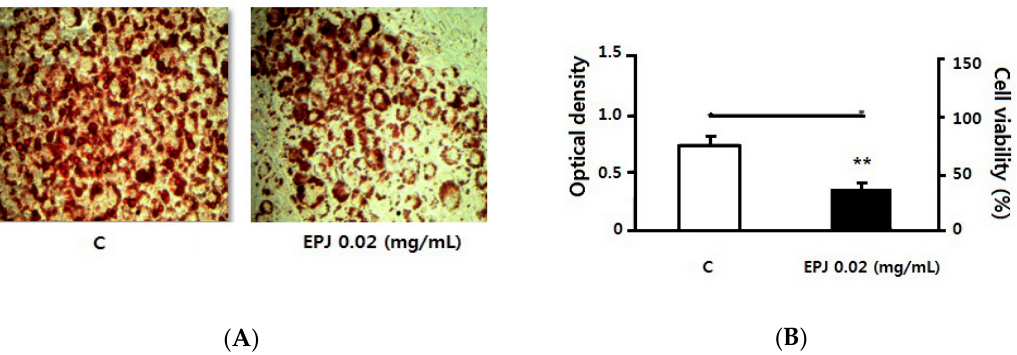
Figure 4. EPJ decreased lipid accumulation in methyl-isobutylxanthine (MDI) medium induced by 3T3-L1 adipocyte di ff erentiation. ( A ) Oil red O image shows that lipid accumulation was visibly decreased in the EPJ 0.02 mg / mL group compared to the control ( C ) group. ( B ) Oil-red O staining was measured semi-quantitatively and optical density was significantly decreased in the EPJ 0.02 mg / mL group compared to the C group. Data are mean ± S.D. of four independent determinations. ** p < 0.01.